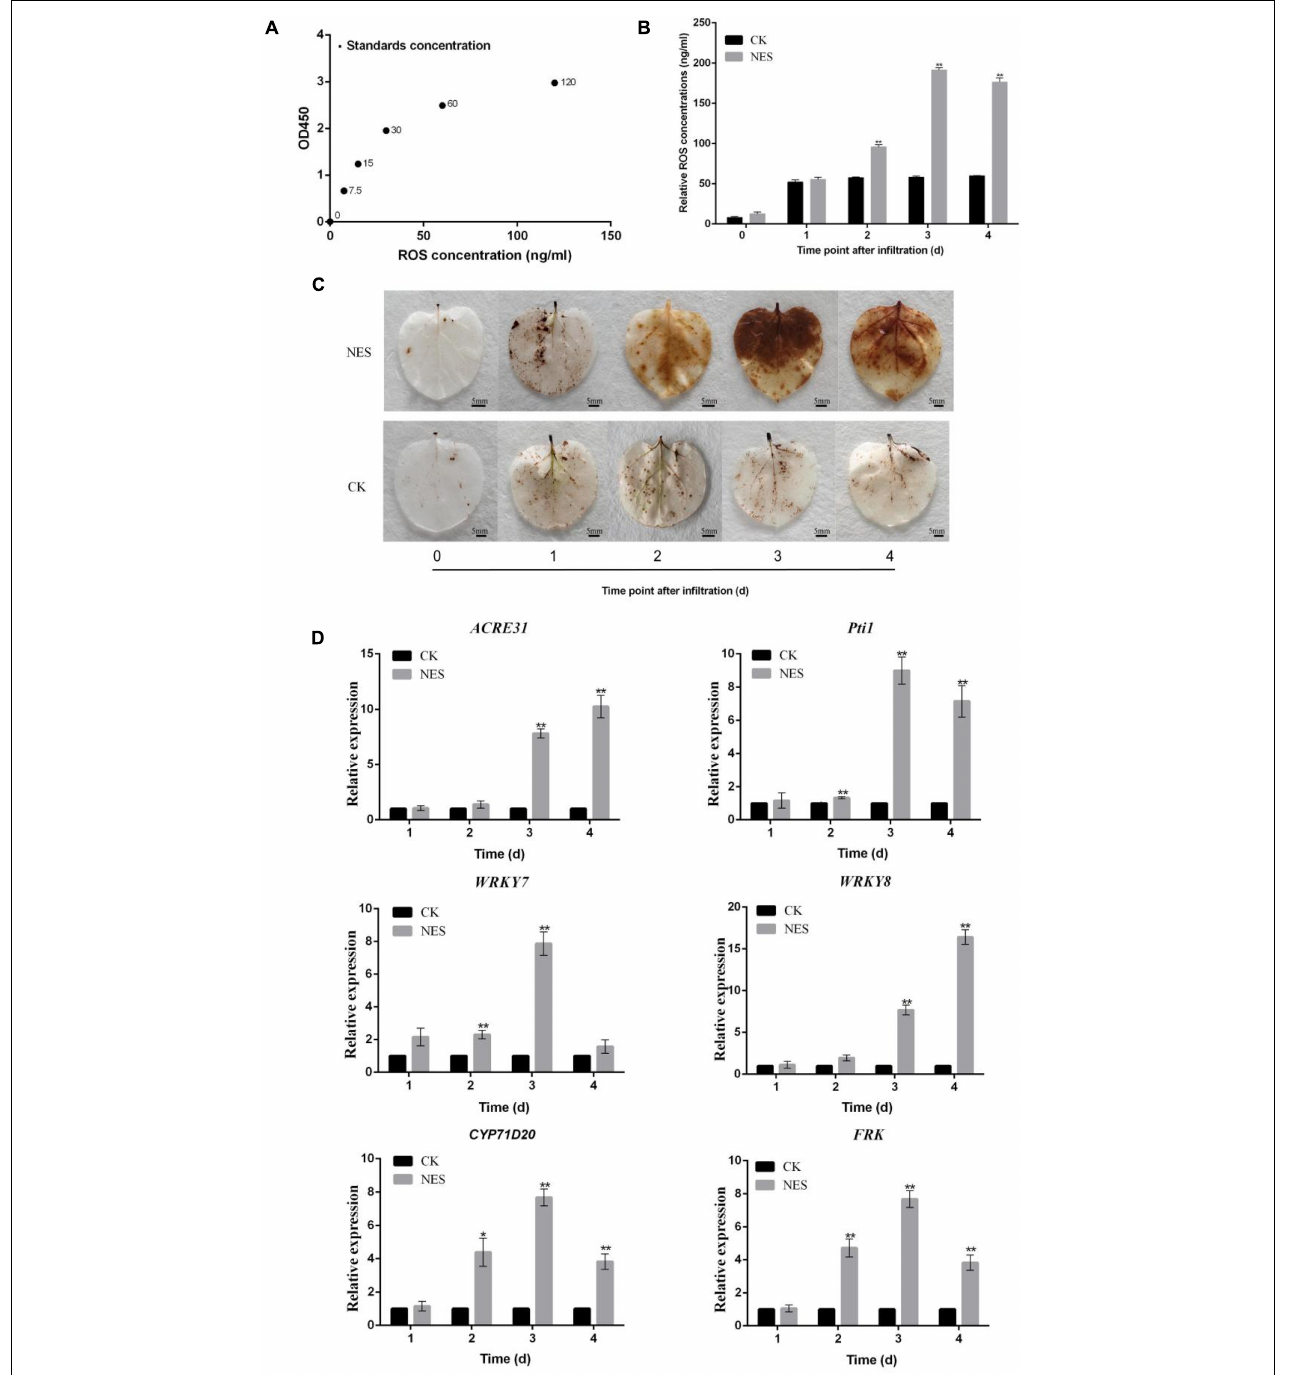
FIGURE 3 | Changes in reactive oxygen species (ROS) and gene expression in response to subtilisin. (A) Standard curve for the determination of ROS concentration. The standard curve was generated by plotting the average OD 450 of the six plant ROS standard concentrations (0, 7.5, 15, 30, 60, and 120 ng/ml) provided in the kit on the vertical axis (X) vs. the corresponding concentration on the horizontal axis (Y). (B) ROS concentration in N. benthamiana leaves expressing pK7WG2D (CK) and pK7WG2D-subtilisin (NES) measured by enzyme-linked immunosorbent assay (ELISA) at 1–4 DAI. (C) Accumulation of ROS was analyzed in N. benthamiana leaves expressing pK7WG2D (CK) and pK7WG2D-subtilisin (NES) at 1–4 DAI. ROS was visualized by 3,3 (cid:48) diaminobenzidine (DAB) staining methods. Brownish deposits were indicative of ROS. (D) Expression analysis of resistance-related genes WRKY7/8, ACRE31, Pti1, CYP71D20, and FRK in N. benthamiana expressing pK7WG2D (CK) and pK7WG2D-subtilisin (NES) at 1–4 DAI. The samples were normalized against Actin and expression levels are represented as fold changes relative to the control. Data presented in (D) are the means ± SD of three independent experiments. The statistical analyses were performed using the Student’s t -test, and asterisks indicate significant differences (* p < 0.05; ** p < 0.01).